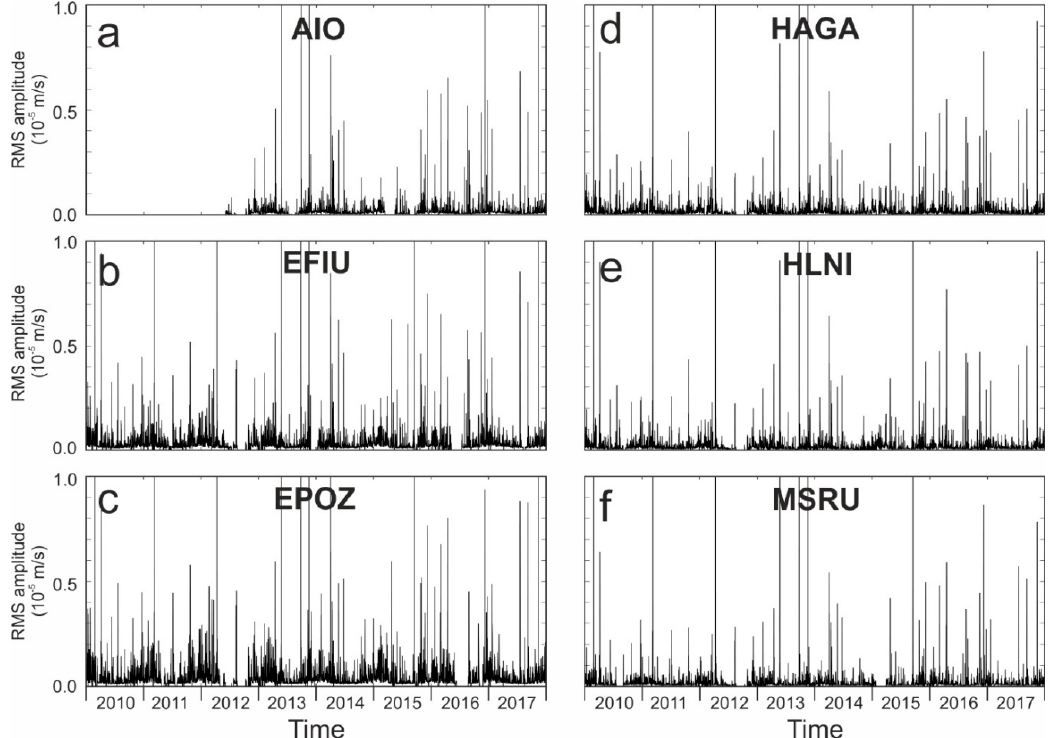
Figure 3. RMS amplitudes of the seismic signal recorded by the vertical component of the six considered stations (a: AIO; b: EFIU; c: EPOZ; d: HAGA; e: HLNI; f: MSRU), and filtered in the band 0.05–0.4 Hz, comprising short-period secondary, secondary, and primary microseisms.